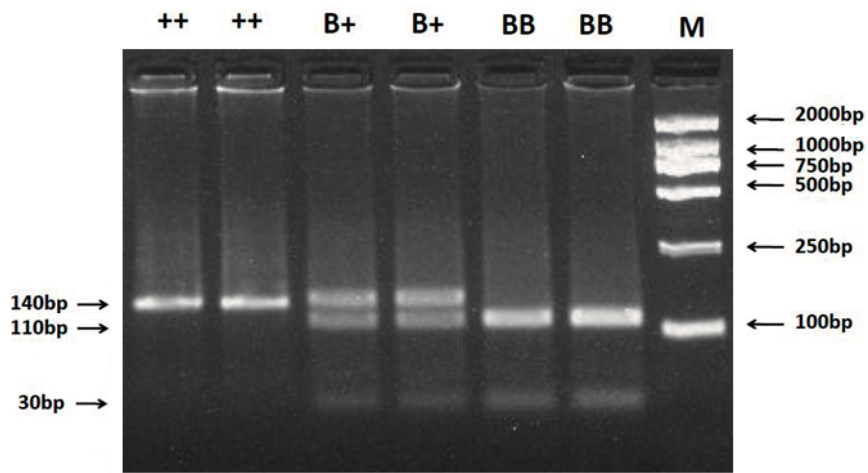
Figure 1. PCR-RFLP results of different genotypes of the PCR products digested by enzyme Ava IIc.746A>G of ovine BMPR-IB polymorphisms. The genotypes are marked on the top of the lanes. M: DNA Marker (DL2000).